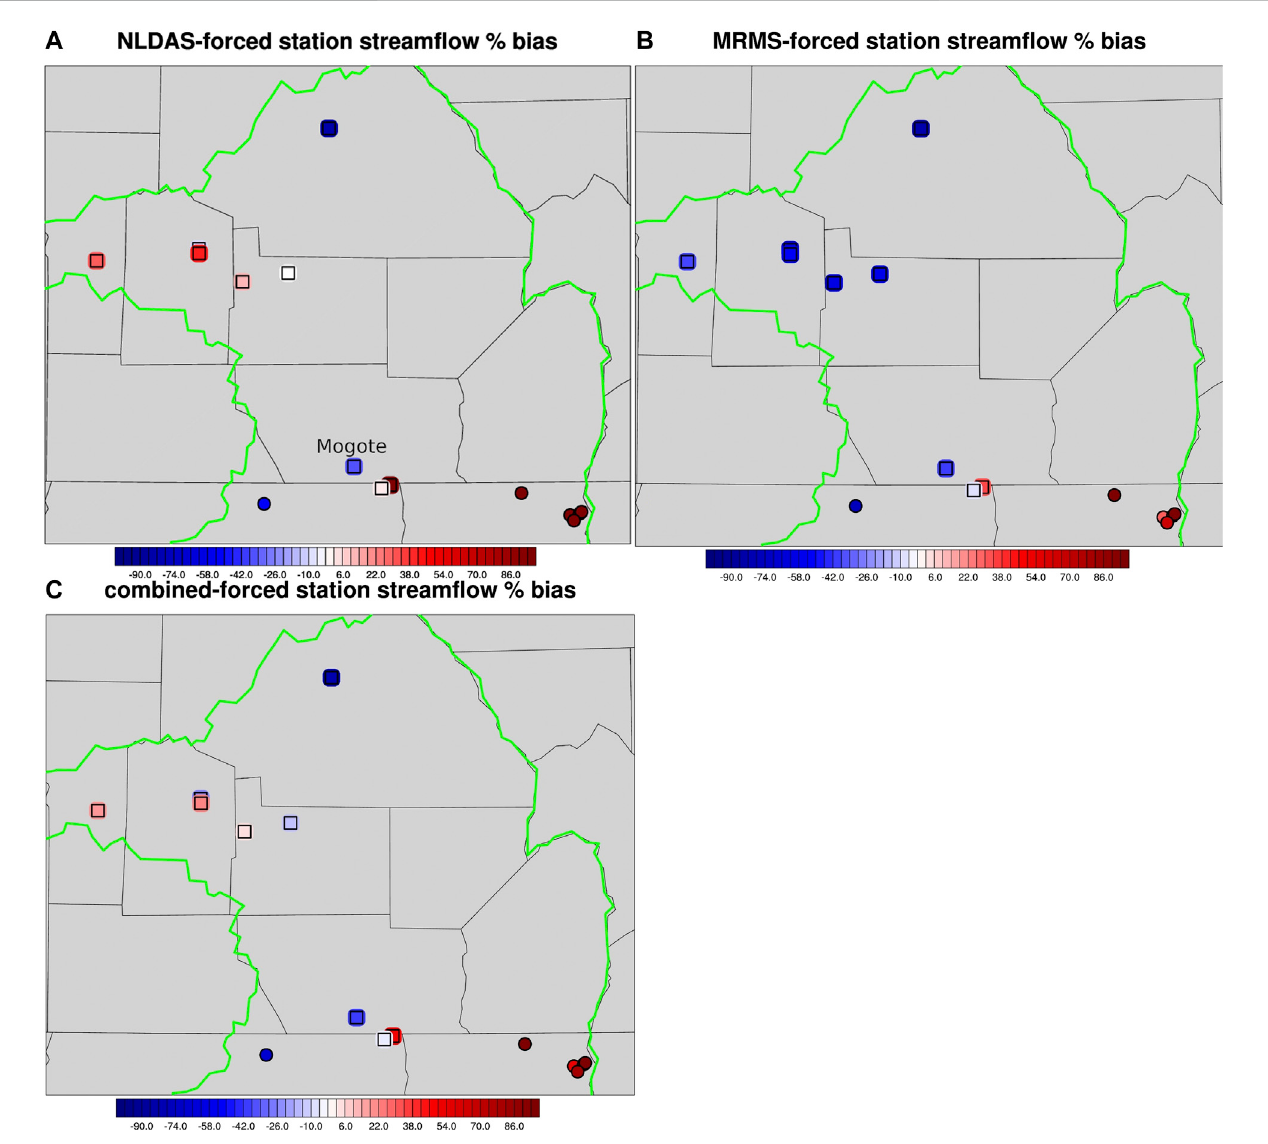
FIGURE 12 Stream fl ow bias for (A) NLDAS, (B) MRMS, and (C) combined versus the observed stream fl ow stations (USGS stations using circles, and CDNR using squares) within the vicinity of the upper Rio Grande basin. The location of the Conejos River near Mogote station depicted in Figure 11 is labelled “ Mogote ” in the fi rst